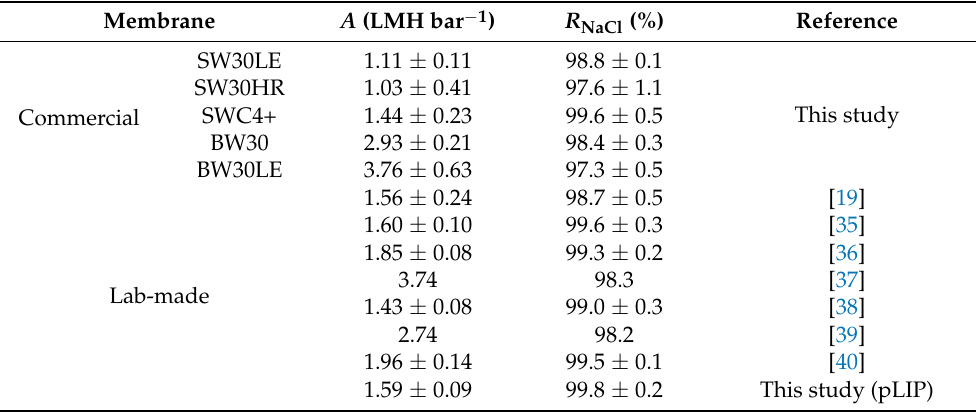
Table 1. Performance comparison of the membranes. Water permeance ( A ) and NaCl rejection ( R NaCl ) of commercial and other reported lab-made RO membranes. The reported performance of lab-made membranes was measured under same operating conditions (feed concentration = 2000 ppm NaCl, operating pressure = 15.5